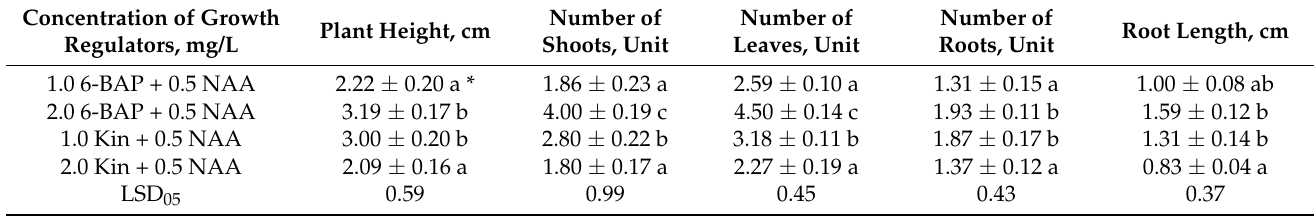
Table 2. Influence of growth regulators on the morphometric parameters of C. erythrostylum plantlets after 120 days of